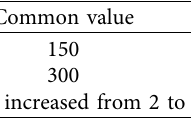
Table 5: The optimal GWO parameters for outputs. Parameter Common